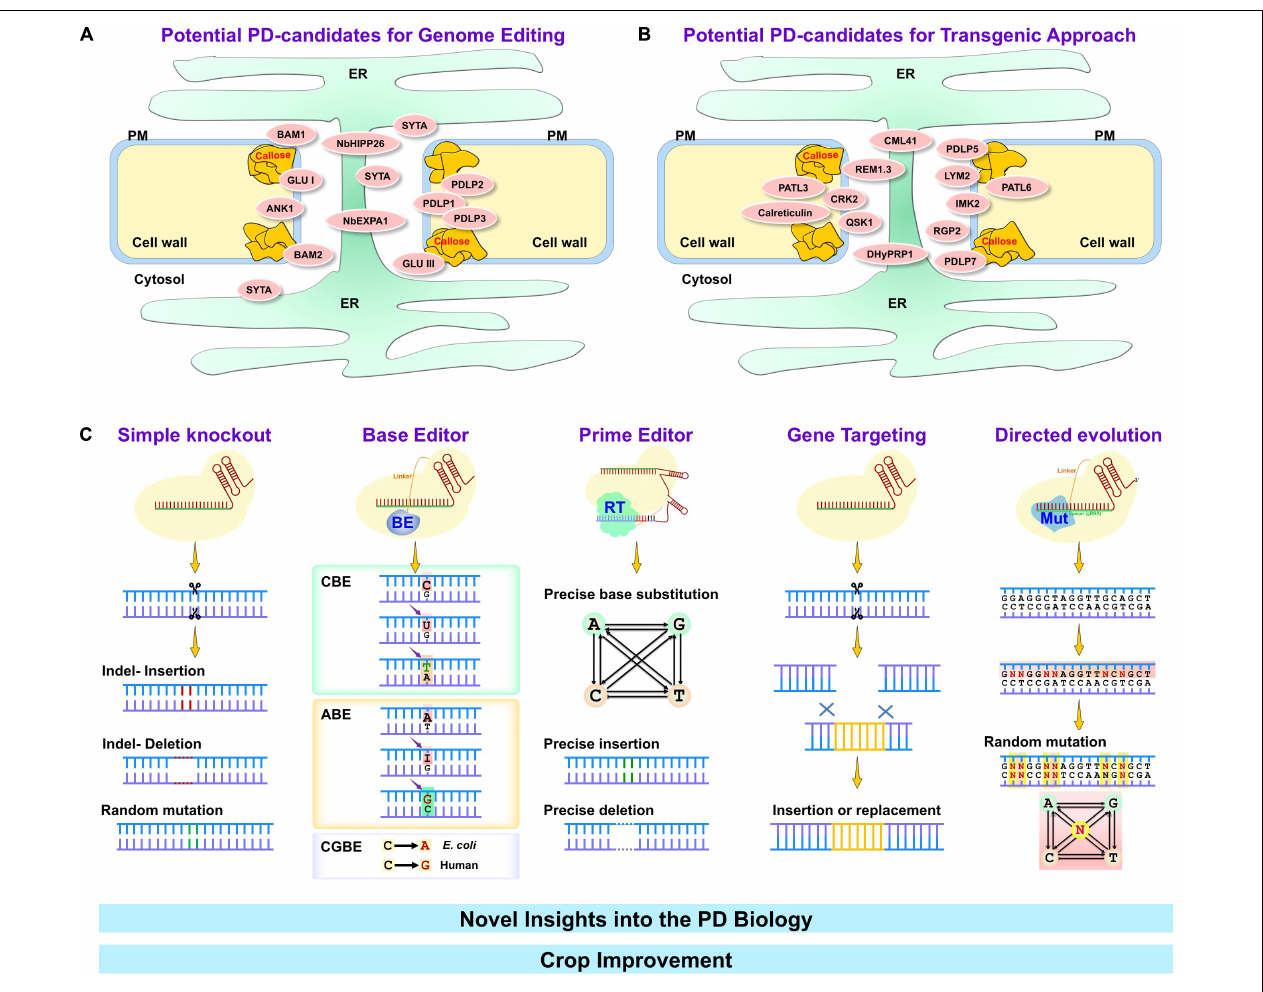
FIGURE 1 | Major genome editing techniques for crop improvement through plasmodesmal engineering. Many PD-associated proteins are involved in a variety of environmental stresses (abiotic and biotic stresses). Depending on the impact on stress mechanism, particular PD-associated proteins can be classified as negative (A) or positive (B) regulators. PD-associated proteins that negatively regulate stress tolerance in plants (summarized in panel A ) can be targeted using genome editing tools such as simple knockout by CRISPR/Cas, base editor, prime editor, gene targeting and directed evolution tools (C) . On the other hand, PD-associated proteins that positively regulate stress tolerance in plants (summarized in panel B ) may provide the easiest way to overexpress them by transgenic approach. Targeting PD-associated proteins by genome editing or transgenically possess potential avenues to improve crop quality and productivity. ER, Endoplasmic reticulum; PM, plasma membrane; BAM1 and 2, barely any meristem 1 and 2; GLU I and III, β -1,3-glucanase class I and III; ANK1, ankyrin repeat-containing protein; SYTA, Synaptotagmin A; NbHIPP26, Nicotiana benthamiana heavy metal-associated isoprenylated plant protein; NbEXPA1, N. benthamiana α -expansin 1; PDLP1, 2, 3, 5, and 7, Plasmodesmata-located protein 1, 2, 3, 5, and 7; PATL3 and 6, patellin 3 and 6; CML41, calmodulin-like protein 41; REM1.3, Remorin 1.3; CRK2, Cys-rich receptor-like kinase 2; QSK1, Qian Shou kinase 1; DHyPRP1, double hybrid proline-rich protein 1; LYM2, lysin motif domain-containing glycosylphosphatidylinositol-anchored protein 2; IMK2, inflorescence meristem kinase 2; RGP2, reversibly glycosylated polypeptide